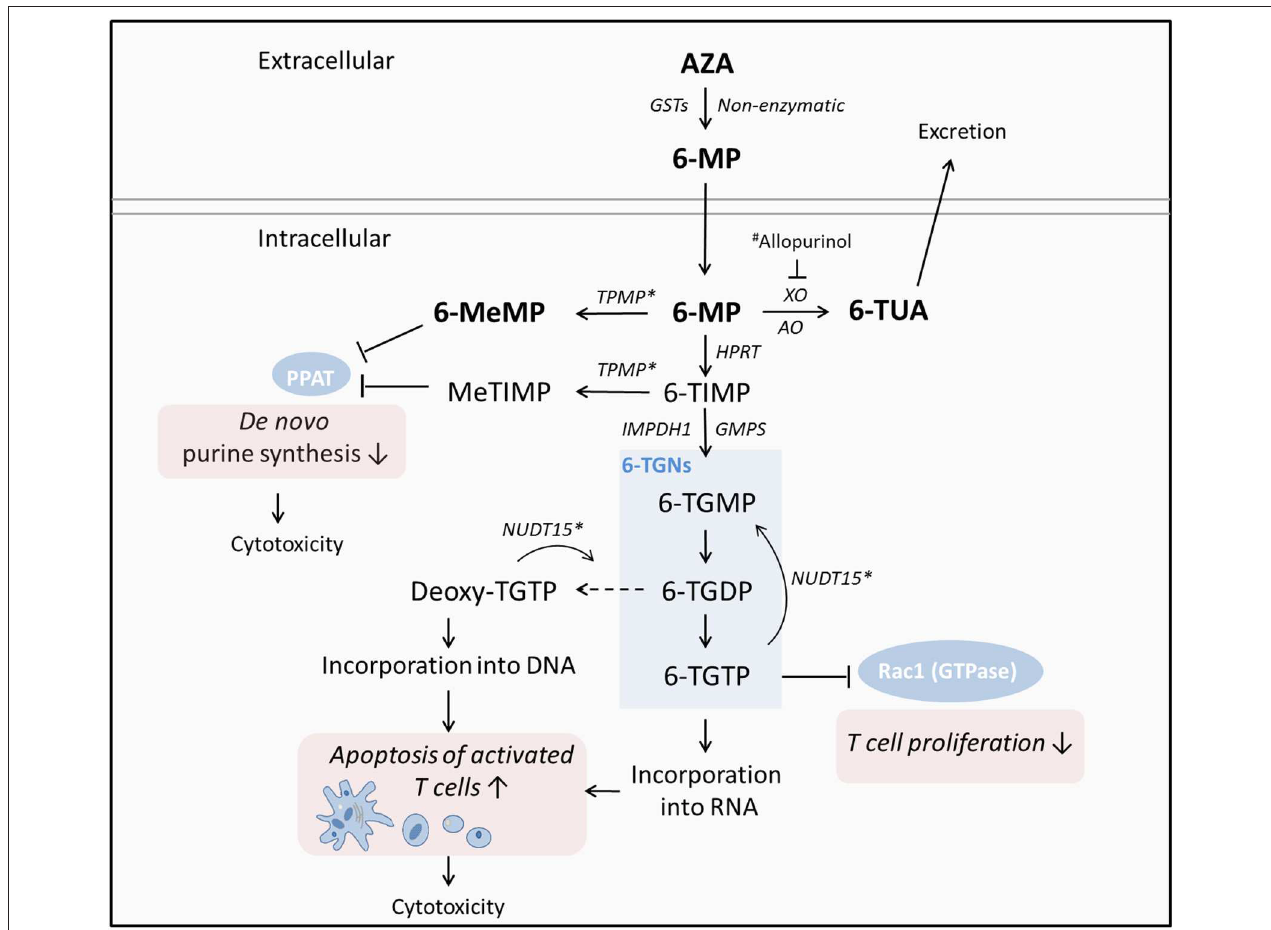
FIGURE 1 | Simplified metabolism of thiopurines and modes of action according to (19–21). As a prodrug, AZA is converted to 6-MP upon reaching the systemic circulation. Following the uptake by transporter molecules, 6-MP is metabolized by three competing pathways either in the liver or gut resulting in immunosuppressive effects. Importantly, 6-TGNs serve as the active metabolites of thiopurine therapy, incorporating into lymphocyte DNA and thereby inducing apoptosis of activated T-lymphocytes as well as exerting direct cytotoxic effects at higher doses. In addition, 6-TGTP inhibits the activity of the GTPase Rac1 resulting in suppression of T cell-dependent immune response. The thiopurine metabolites 6-MeMP and MeTIMP inhibit the enzyme PPAT which catalyzes the first step of de novo purine synthesis; resulting in inhibition of DNA synthesis and cell proliferation along with cytotoxic effects. AZA, Azathioprine; 6-MP, 6-mercaptopurine; TPMT, thiopurine S-methyltransferase; TUA, thiouric acid; HPRT, hypoxanthine phosphoribosyltransferase; MeMP, methylmercaptopurine; TIMP, thioinosine monophosphate; TGNs, thioguanine nucleotides; XO, xanthine oxidase; AO, aldehyde oxidase; TGMP, guanosine monophosphate; TGDP, guanosine diphosphate; TGTP, guanosine triphosphate, NUDT15, nudix hydrolase 15; PPAT, phosphoribosyl pyrophosphate aminotransferase; Rac1, Rac family small GTPase 1. * Associated with variability in tolerance to thiopurines. # XO inhibitor allopurinol, applied to induce a switch toward 6-TGN production in patients who do not adequately respond to thiopurine